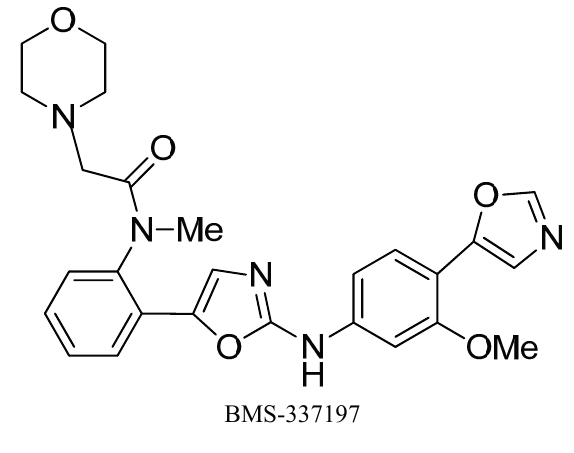
Figure 5. A novel IMPDH